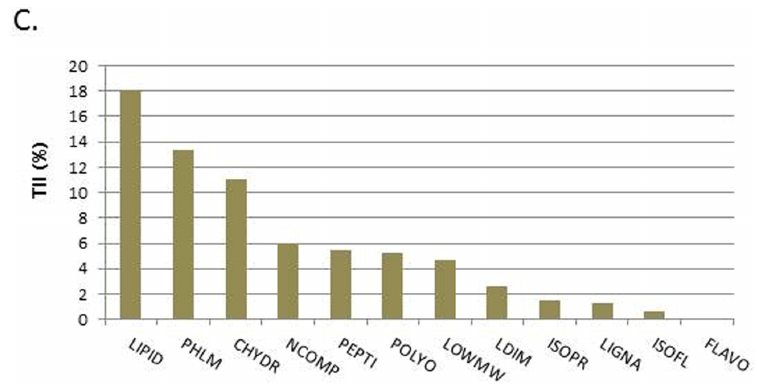
Figure 1. Characteristic diagram of mass spectrometry analysis results of the EFE using both the microwave extraction ( A ) and the extraction method modified from Luyengi et al. [26] ( B ); moreover, the different substances extracted are presented ( C ).